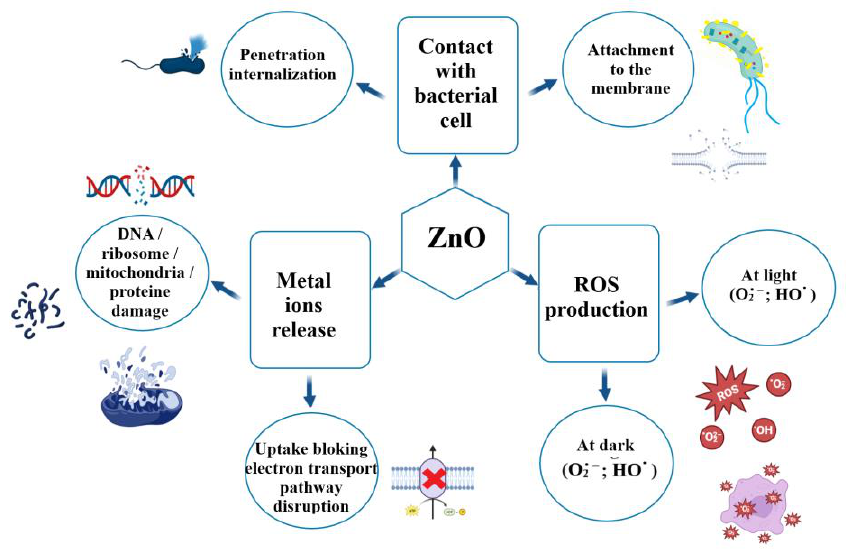
Figure 14. Graphic representation of proposed antibacterial mechanisms for ZnO nanoparticles.